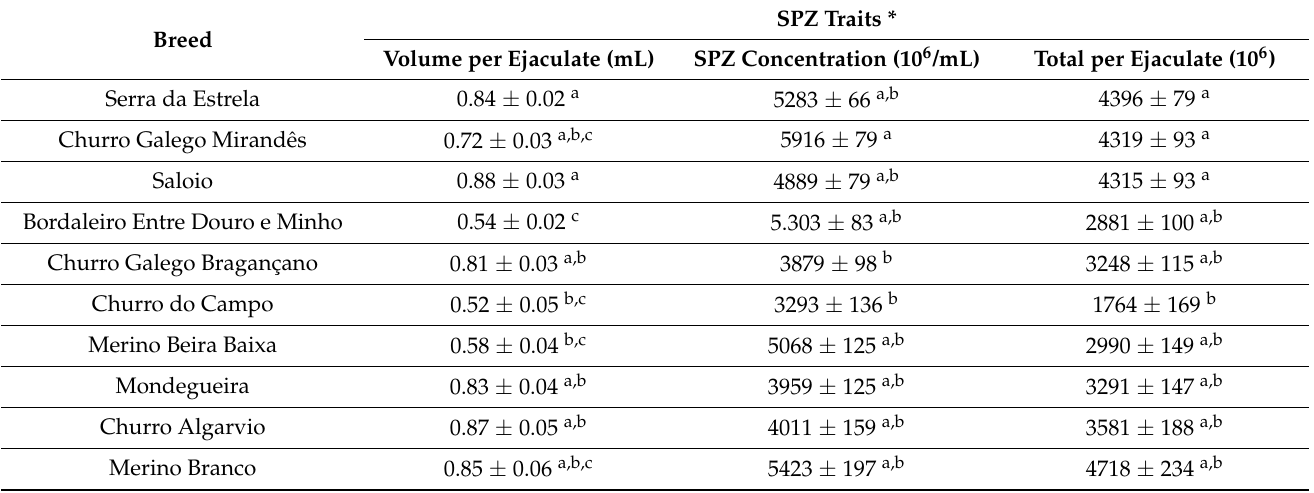
Table 3. Ejaculate volume, spermatozoa concentration, and total sperm per ejaculate in the 10 local ram breeds ( n =